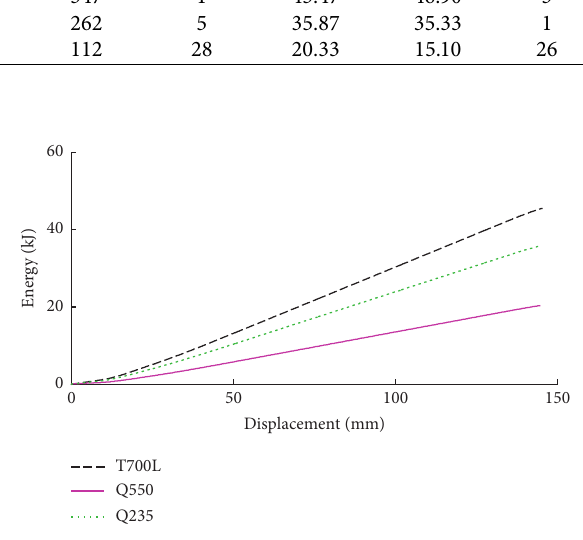
Figure 7: Energy absorption characteristics of